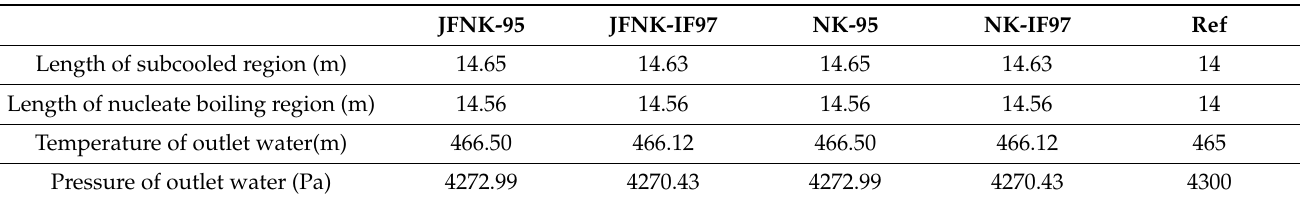
Table 7. Simulation results in steady-state HTR-10 steam generator model using different algorithms and water properties routines.